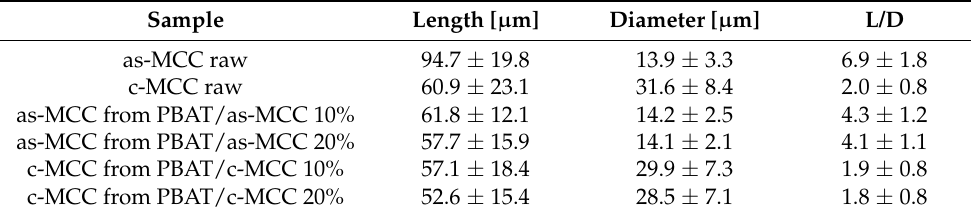
Table 1. Length, diameter and L/D ratio of as-MCC and c-MCC raw and extracted from PBAT-based composites.